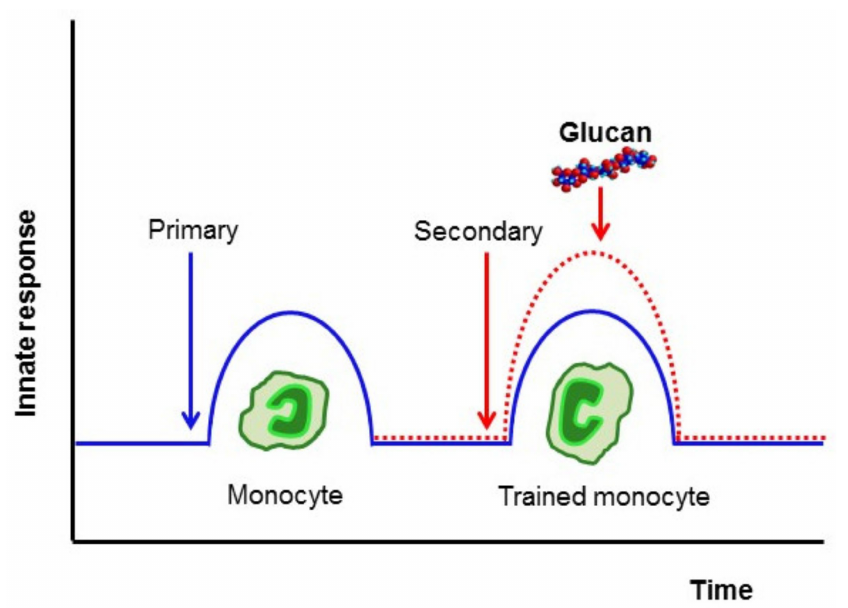
Figure 2. Basic concept of trained immunity. Dotted line shows classical concept, full line shows trained